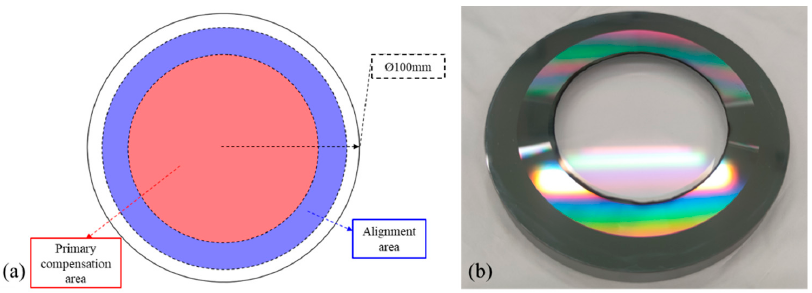
Figure 16. Design and fabrication of CGH compensation. ( a ) CGH design; ( b )